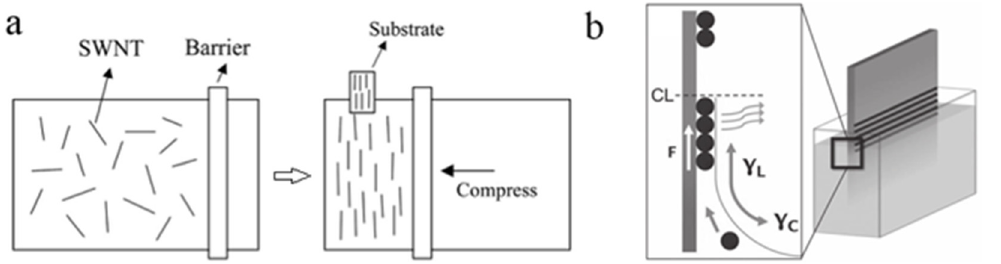
Figure 11. ( a ) Process of LB film technique. Reproduced with permission [84]. Copyright 2008, AIP Publishing. ( b ) schematic of the evaporation-driven assembly method. Reproduced with permission [85]. Copyright 2012, John Wiley and Sons.